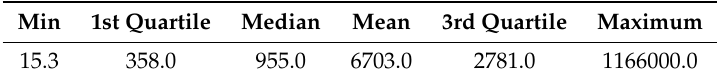
Table 4. Summary of non-life insurance claims (EUR) n =